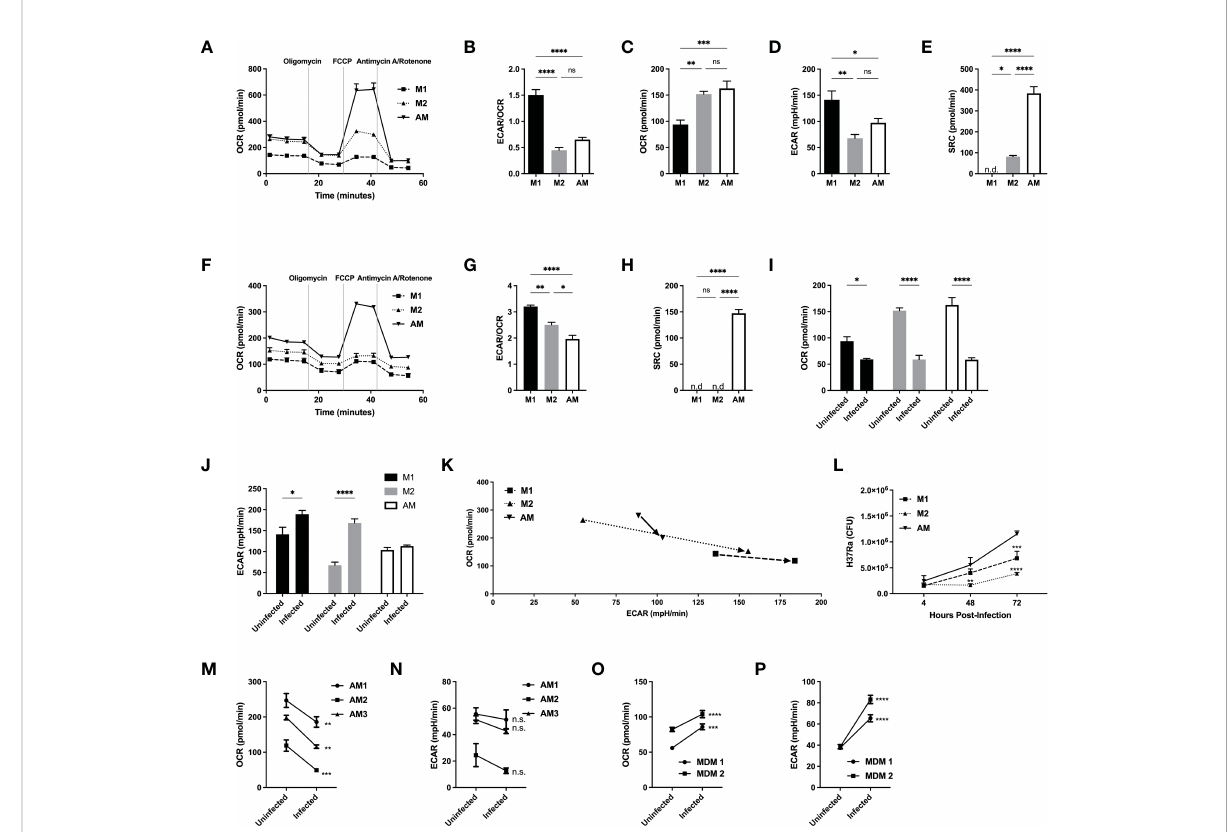
FIGURE 2 Alveolar macrophages have a unique metabolic signature, distinct from M2 macrophages and do not switch to a glycolytic phenotype following avirulent (H37Ra) Mtb infection. M1 and M2 bone marrow-derived and naïve alveolar macrophages were subjected to a Seahorse assay to measure cellular metabolism before (A – E) and after 24hrs of infection (F – K) with H37Ra at MOI of 2.5. (A) Oxygen consumption rate (OCR) curve following sequential injections of mitochondrial inhibitors oligomycin, FCCP and antimycin/rotenone (Ant Rot). (B) Ratio of extracellular acidi fi cation rate (ECAR)/OCR. (C) Quanti fi cation of basal levels of oxygen consumption, (D) ECAR, (E) spare respiratory capacity (SRC). (F) Oxygen consumption rate (OCR) curve of infected macrophages following sequential injections of mitochondrial inhibitors oligomycin, FCCP and antimycin/rotenone. (G) Ratio of ECAR/OCR of infected macrophages. (H) Quanti fi cation of spare respiratory capacity of infected macrophages. Shift in (I) OCR and (J) ECAR following infection, illustrated in (K) . (L) M1 and M2 bone marrow-derived and naïve alveolar macrophages were infected at MOI 2.5 with H37Ra and subjected to CFU assays. (M – P) Human alveolar macrophages and PBMC-derived MDMs were subjected to a Seahorse assay to measure cellular metabolism before and after 24hrs of infection with H37Ra at a MOI of 2.5. Oxygen consumption rate (OCR) shift of hAM (M) and MDM (O) prior and after infection. Extracellular acidi fi cation rate shift of hAM (N) and MDM (P) prior and after infection. Data are given as mean ± SEM. The results are representative of 2 independent experiments (A – L) and 3 (M, N) or 2 (O, P) independent healthy donors. * p<0.05; ** p<0.01; *** p<0.001; **** p<0.0001 (1-way ANOVA followed by Tukey comparison) (D, E, M – P) 2-way ANOVA followed by Bonferroni comparison or Sidak ’ s